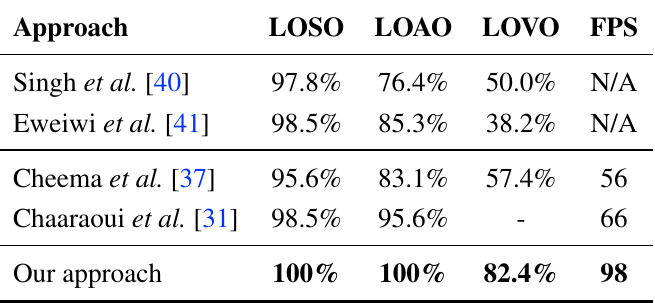
Table 4. Comparison of recognition rates and speeds obtained on the MuHAVi-8 dataset with other state-of-the-art approaches. LOVO, leave-one-view-out.